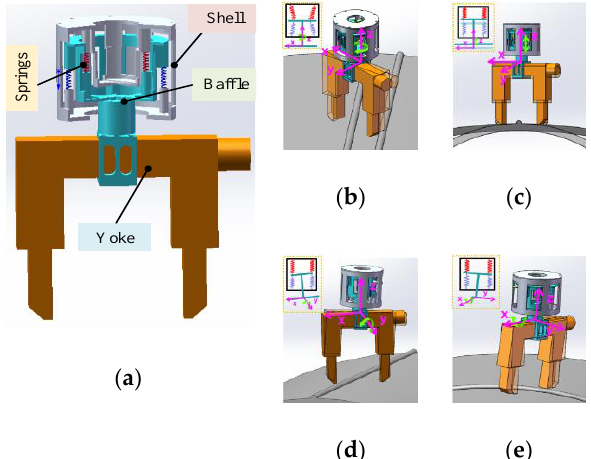
Figure 5. Flexible mechanism. ( a ) Structure of flexible mechanism; ( b – e ) principle of flexible adaptation.